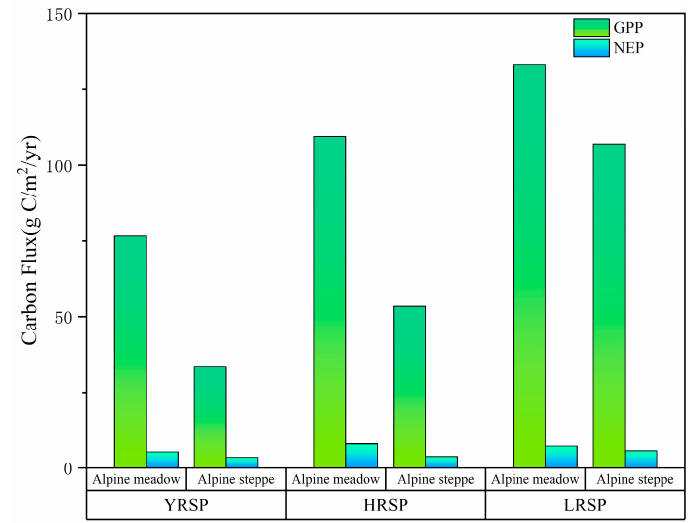
Figure 10. Carbon fluxes in the alpine meadow and alpine steppe of the three sub-park regions.